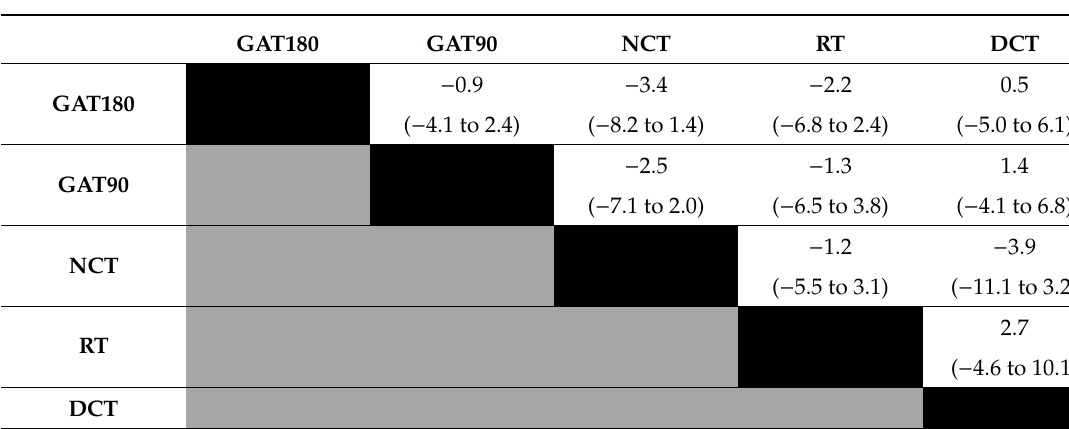
Table 2. Mean di ff erences (and 95% limits of agreement) for intraocular pressure (IOP) measurements obtained by each